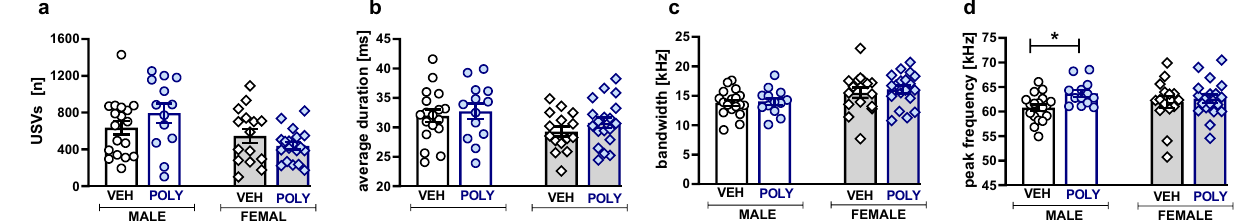
Figure 3. Vocalizations during the social interaction test: total USV emission. Poly(I:C) exposure did not affect the total number ( a ), average duration (b), and bandwidth (c) but increased the peak frequency ( d ) of emitted calls in males. Data are presented as a mean ± SEM. Symbols: *p < 0.05, a significant difference between vehicle- and poly(I:C)-exposed males (planned comparisons).